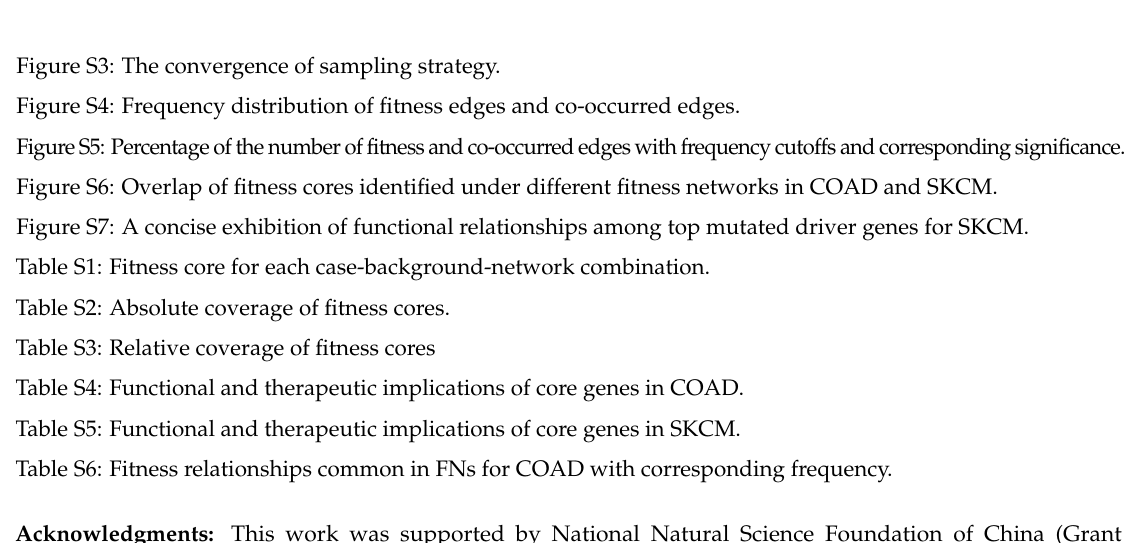
Figure S3: The convergence of sampling strategy. Figure S4: Frequency distribution of fitness edges and co-occurred edges.